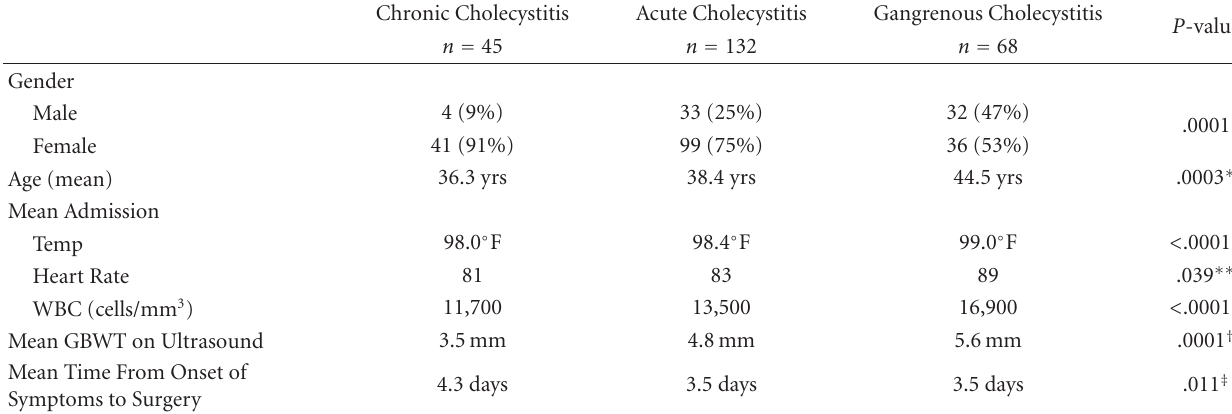
Table 3: Clinical characteristics of patients by pathologic diagnosis.